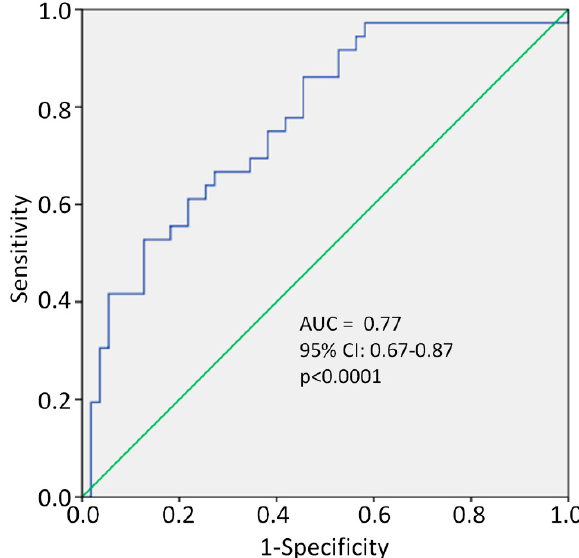
Figure 2. Receiver operating characteristic (ROC) curve of propensity score for vitamin D treatment, including smoking, serum D-dimer and 25(OH)D levels and comorbidity burden. AUC = area under the curve, CI = confidence interval.